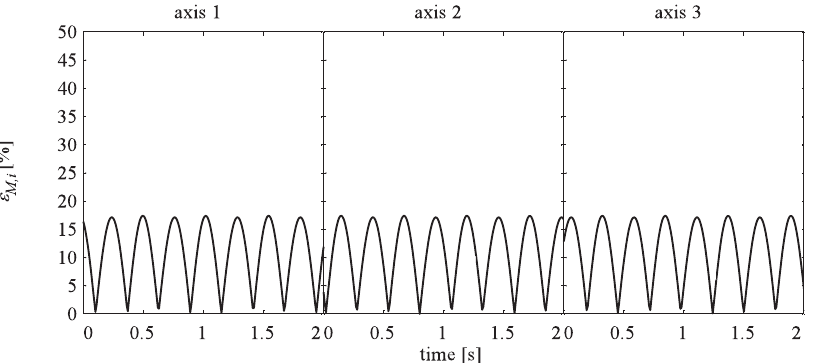
Figure 14. Di ff erence between contributions of full mass matrix M and diagonalized mass matrix M 0 .